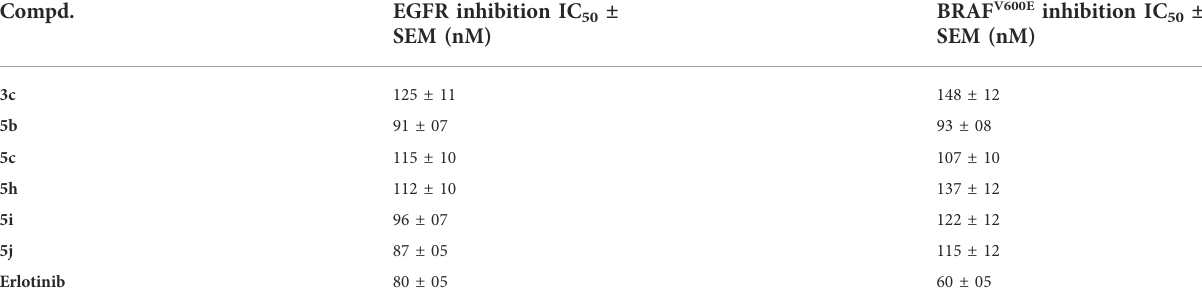
TABLE 5 IC 50 of compounds 3c, 5b, 5c, 5h, 5i, and 5j against EGFR and BRAF V600E .